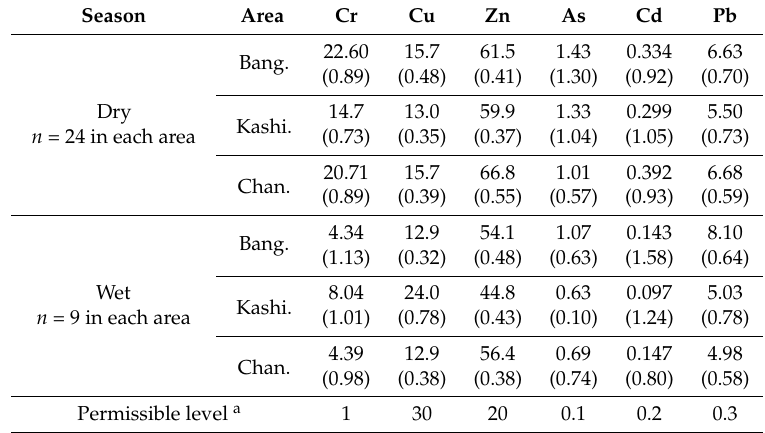
Table 3. Mean and coefficient of variation (in parentheses) of heavy metal concentration (mg/kg) of vegetables in dry and wet seasons in the three areas.